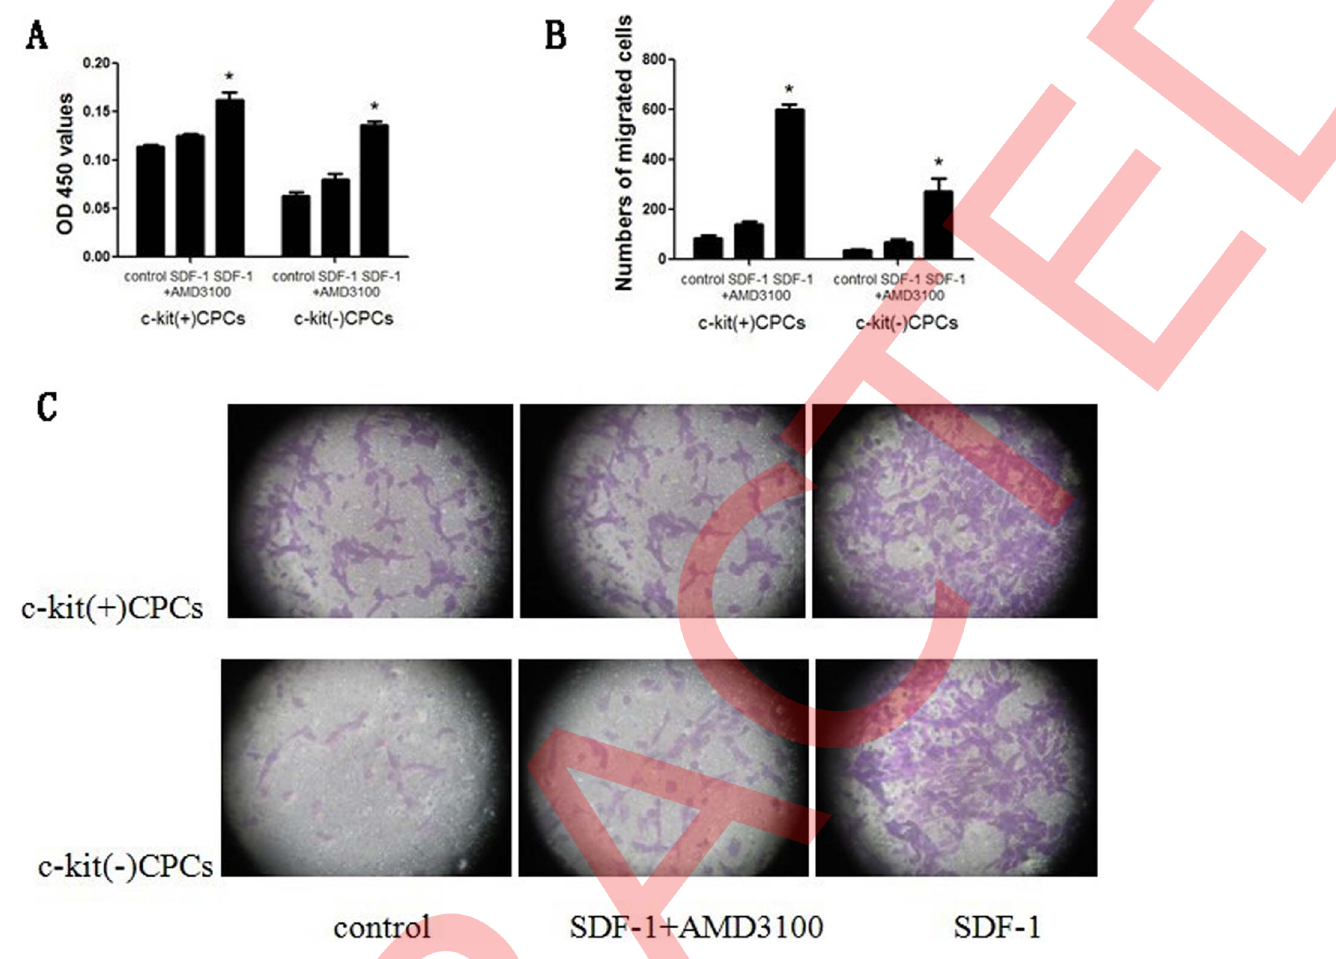
Figure 3. SDF-1 a enhances the proliferation and migration of. (A) CPCs were stimulated with 100 ng/ml SDF-1 a and 5 m g/ml AMD3100 for 48 hours. And CCK-8 assay was used to determine the proliferation. (B) Quantitative analysis of migrated cells. (C) Representative migrated CPCs (stained with crystal violet) are shown ( 6 200 magnification). Data were obtained from three independent experiments and are expressed as mean 6 SD.n = 3.rol group.n of cit and GAPHD.0.Western blot wa c-kit at both protein and mRNA level * P , 0.05 vs. control group. The Figure 3C panels are excluded from the article's CC-BY license. See the accompanying retraction notice for more information.